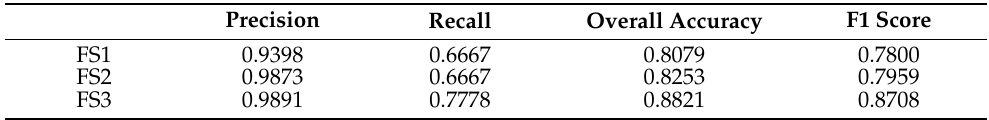
Table 7. Classification accuracy for the grassland distribution identification based on input feature